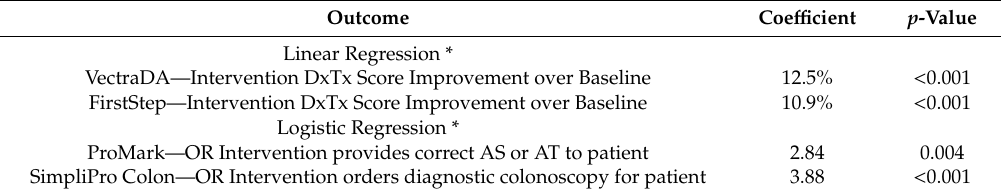
Table 3. Clinical utility demonstration of each novel